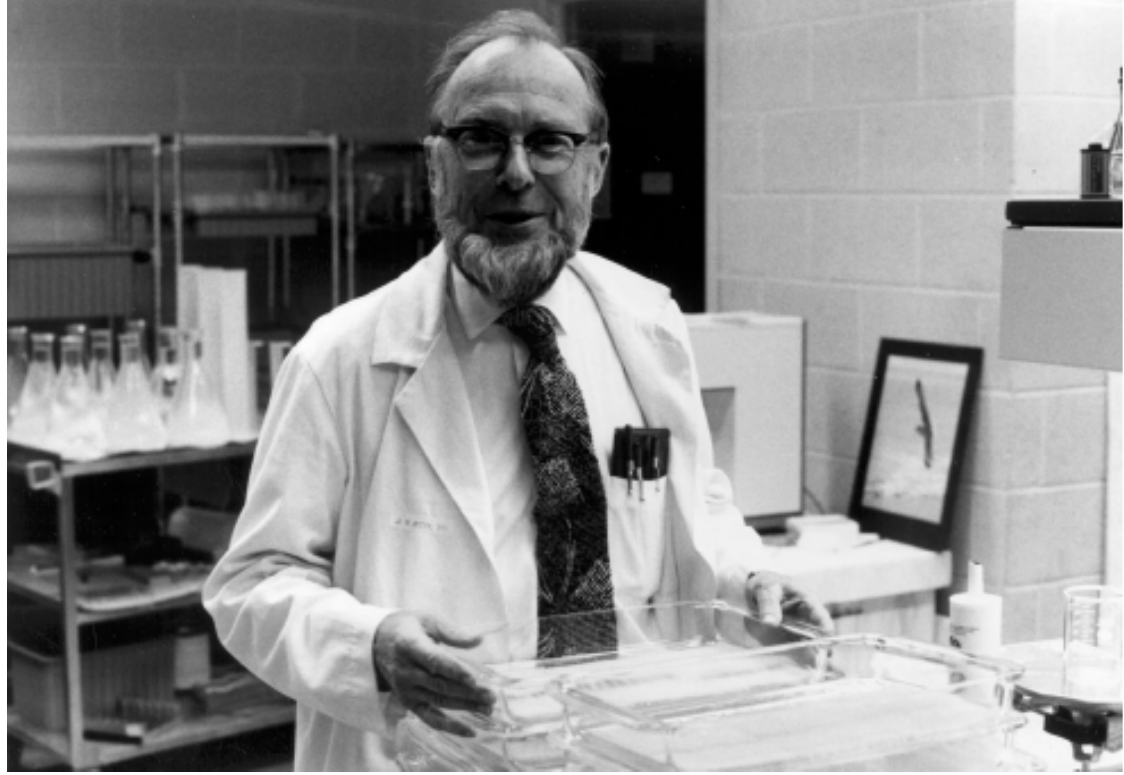
Figure 1 - James V. Neel examining the results of electrophoretic runs at his laboratory in Ann Arbor in the late 1970’s.